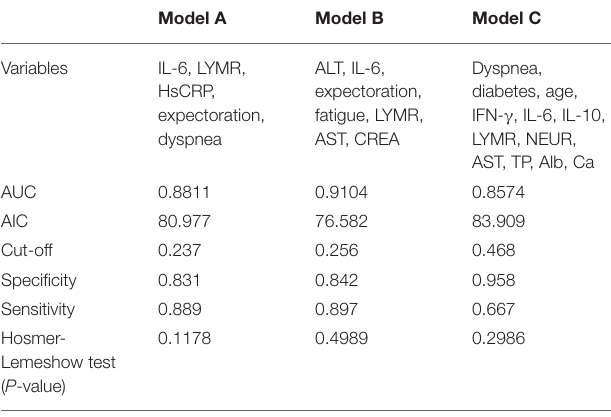
TABLE 2 | Comprehensive performance of three prediction models.